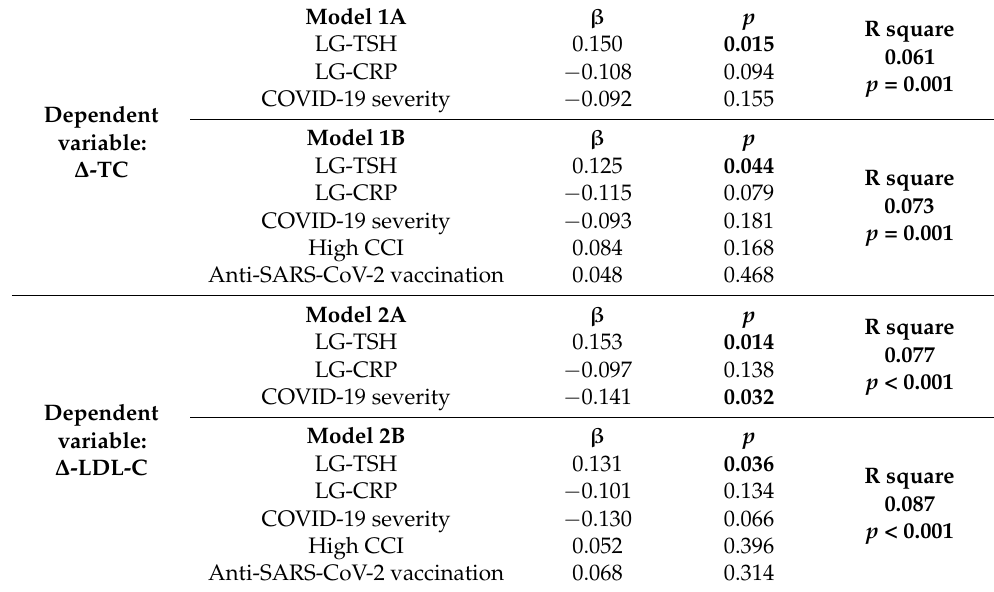
Table 3. Association between TSH and either ∆ -TC, ∆ -LDL-C, or ∆